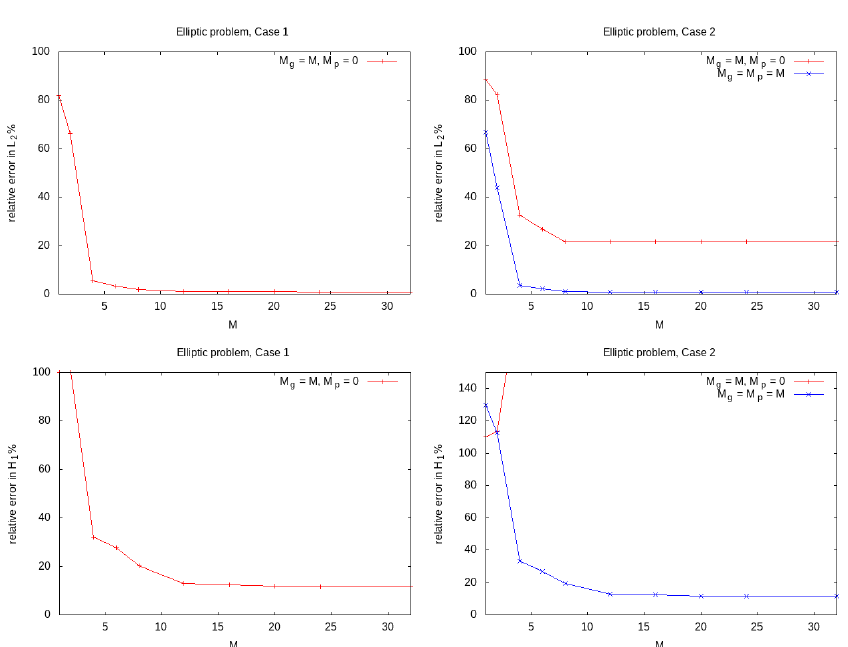
Figure 8. Elliptic problem with α = 100. Case 1 ( left ) and Case 2 ( right ): Relative L 2 ( top ) and H 1 ( bottom ) error with a different number of multiscale basis